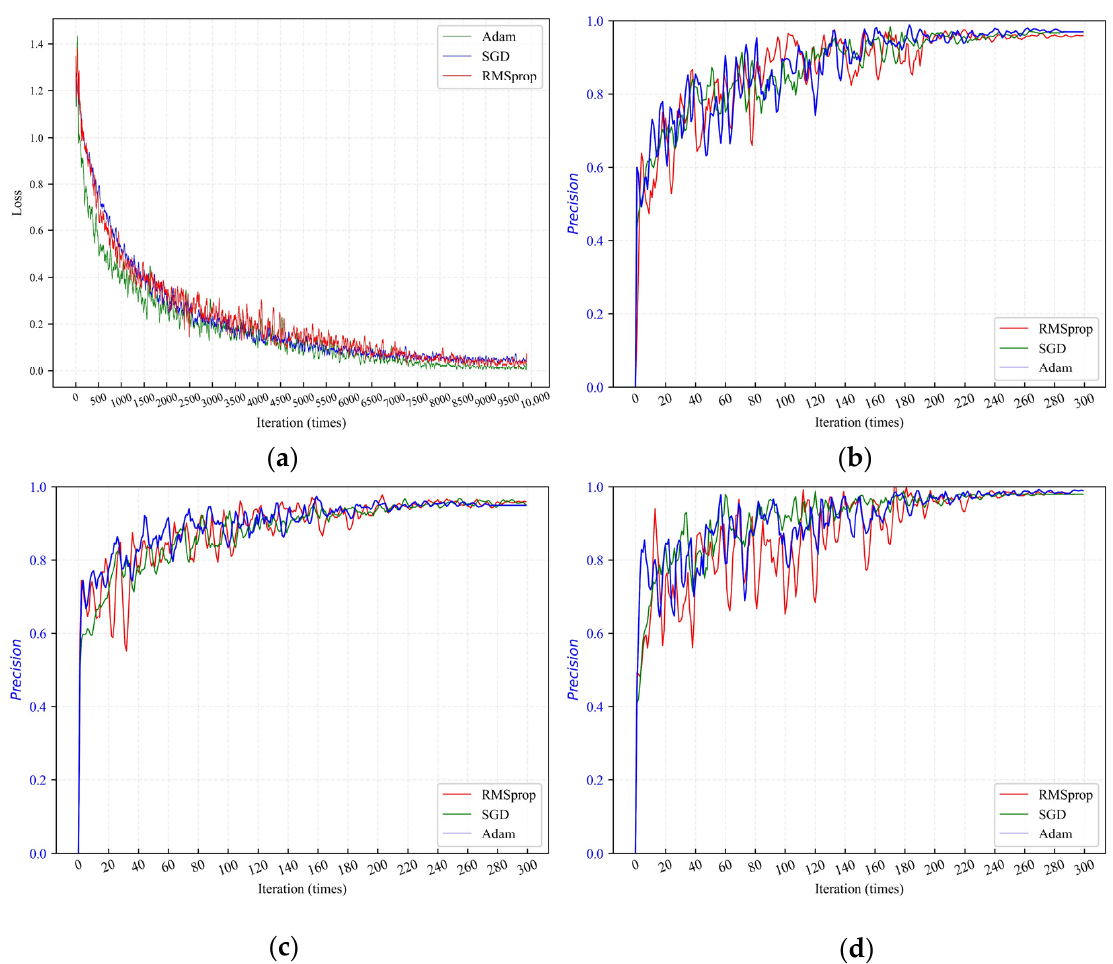
Figure 13. ( a ) Training loss of VGG16 under three optimizers; ( b ) classification precision of metamorphic rock under three optimizers; ( c ) classification precision of sedimentary rock; and ( d ) classification precision of volcanic rock.